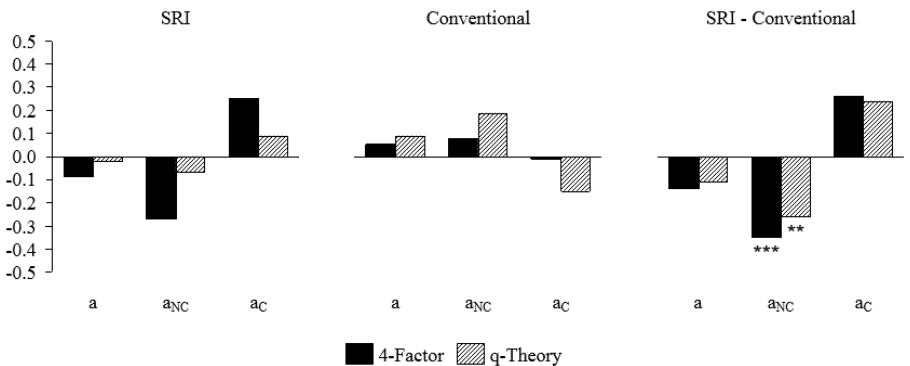
Fig. 1. Financial performance: alpha estimates in percent per month